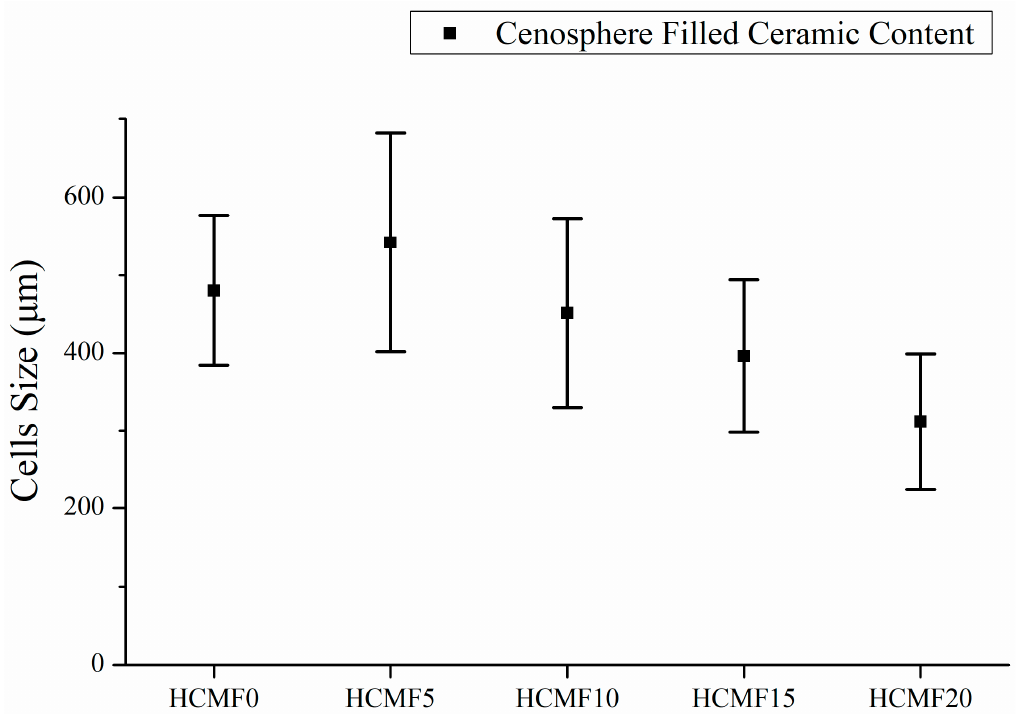
Figure 6. Average cell size of HCMF composites as related to the HCM content.